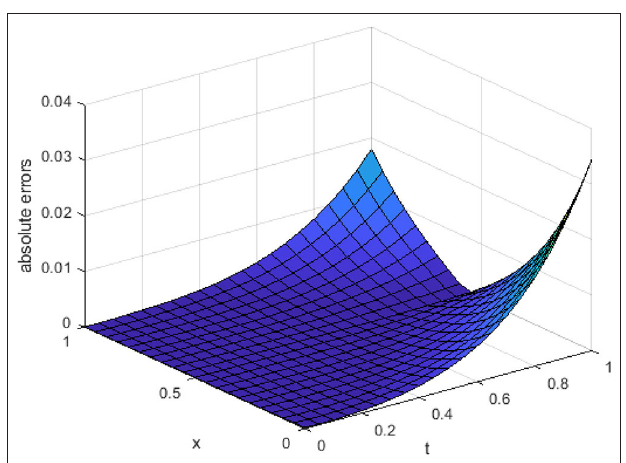
FIGURE 2 | Absolute errors at β = 2.